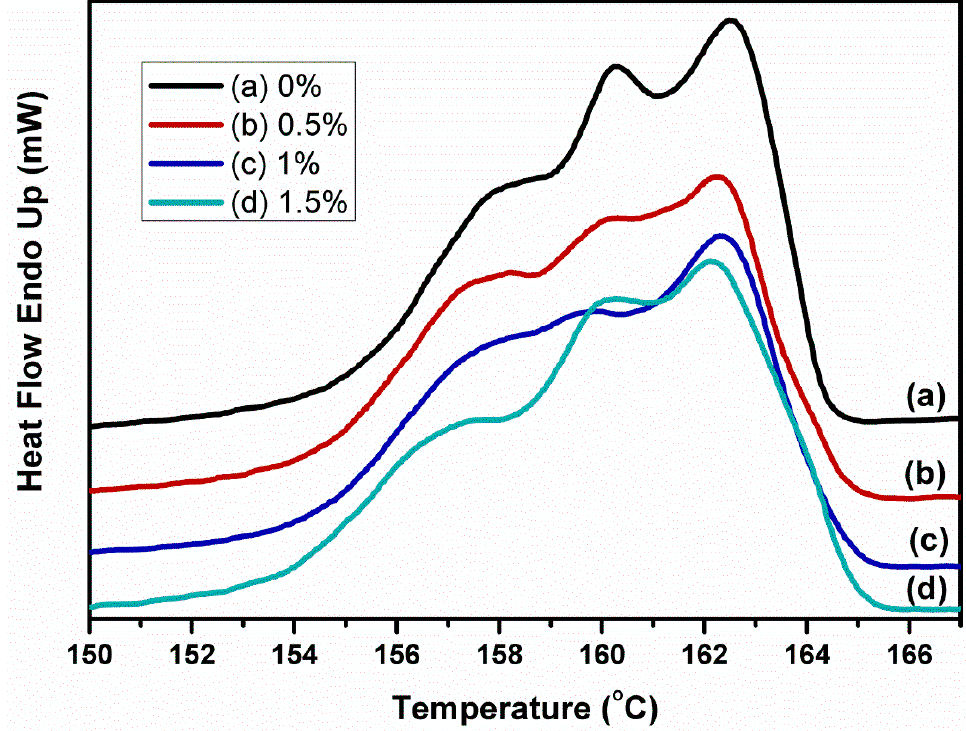
Figure 7. The DSC diagram of PLLA-PEG200 copolymer with adding different amounts of o-MMT. These DSC melting curves resulted from twice heating under non-isothermal melting crystallization. The amount of o-MMT was ( a ) 0 wt%, ( b ) 0.5 wt%, ( c ) 1 wt%, and ( d ) 1.5 wt%, re- spectively.